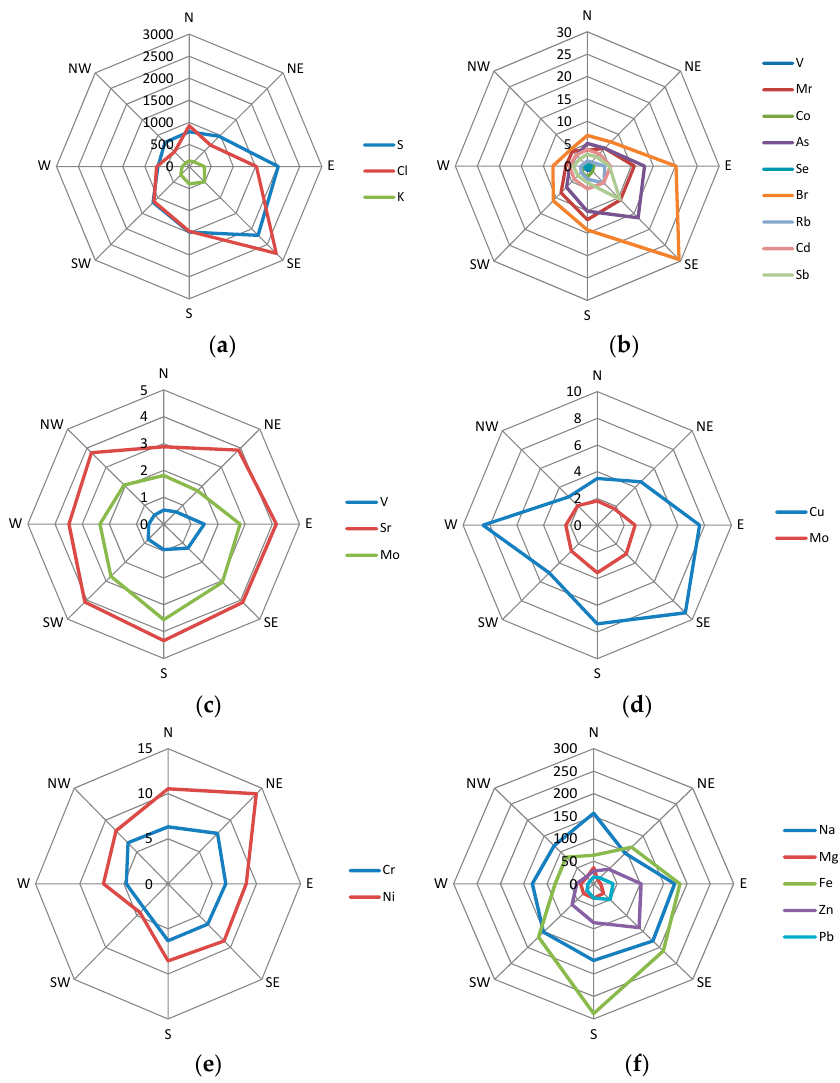
Figure 4. Concentrations (ng·m − 3 ) of the selected PM 2.5 -bound elements averaged for 2011–2012 for the selected air mass inflow directions in Racibórz: ( a ) S, Cl, K; ( b ) V, Mn, Co, As, Se, Br, Rb, Cd, Sb; ( c ) V, Sr, Mo; ( d ) Cu, Mo; ( e ) Cr, Ni; ( f ) Na, Mg, Fe, Zn, Pb.